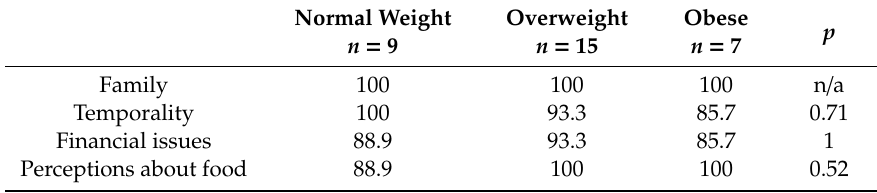
Table 3. Comparison of percentage of participants who mentioned a theme by participant’s weight status.